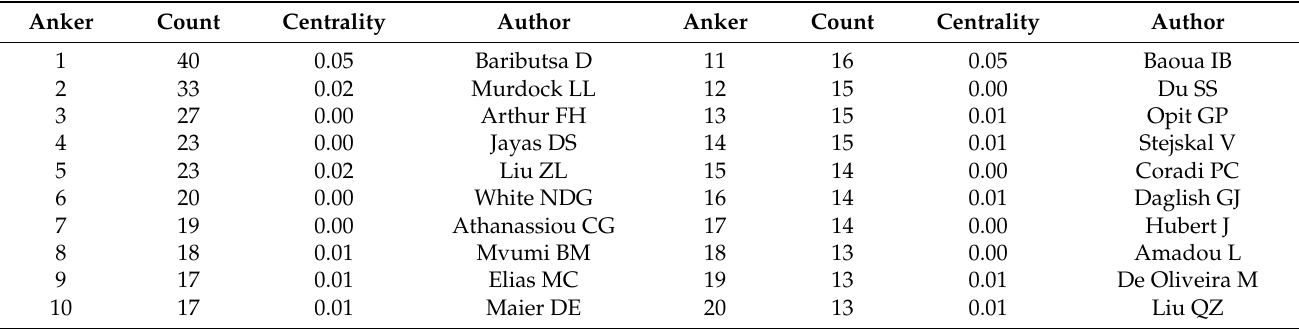
Figure 3. Author cooperation network map. Table 2. Author information table of the top 20 published articles.